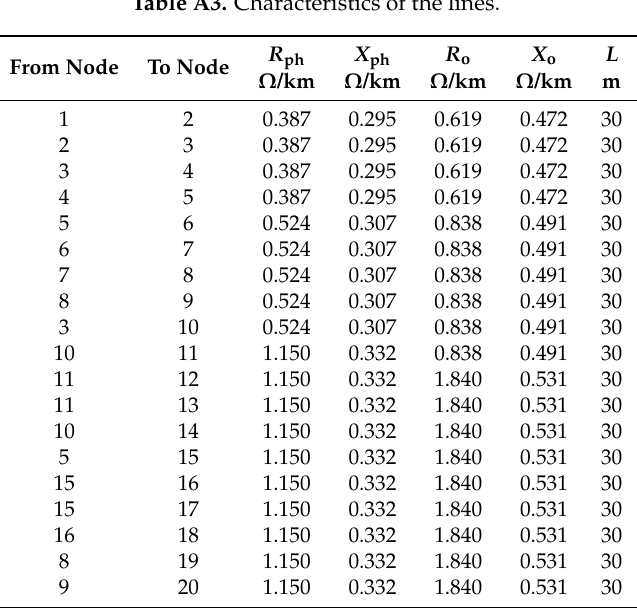
Table A3. Characteristics of the lines.